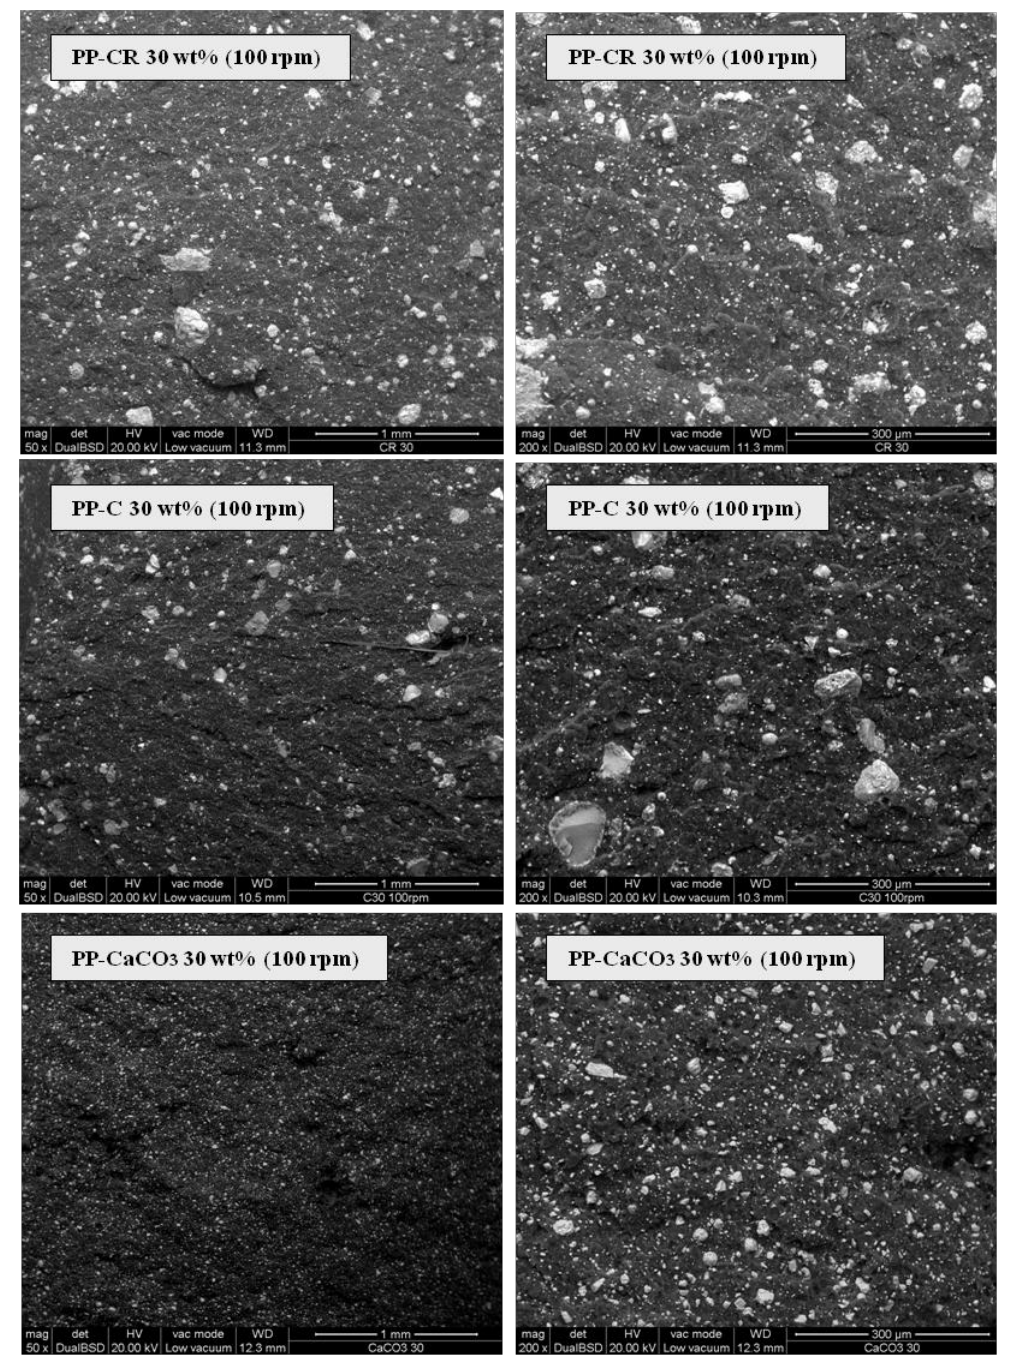
Figure 6. Scanning electron microscopy (SEM) analysis on cryofractured samples surfaces obtained with different fillers (30 wt% amount, 100